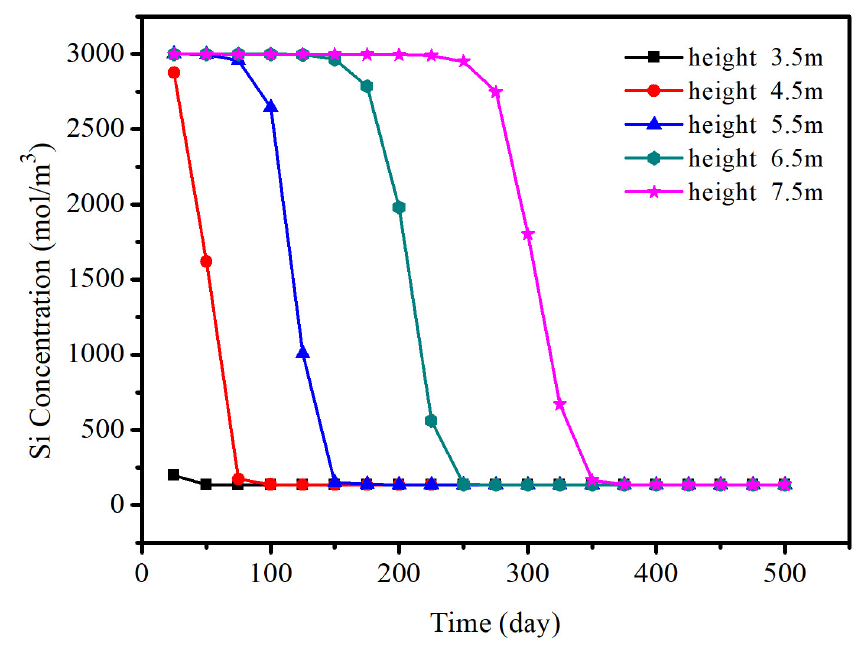
Figure 12. The variation of Si concentration with time at different position at Si concentration of 3000 mol/m 3